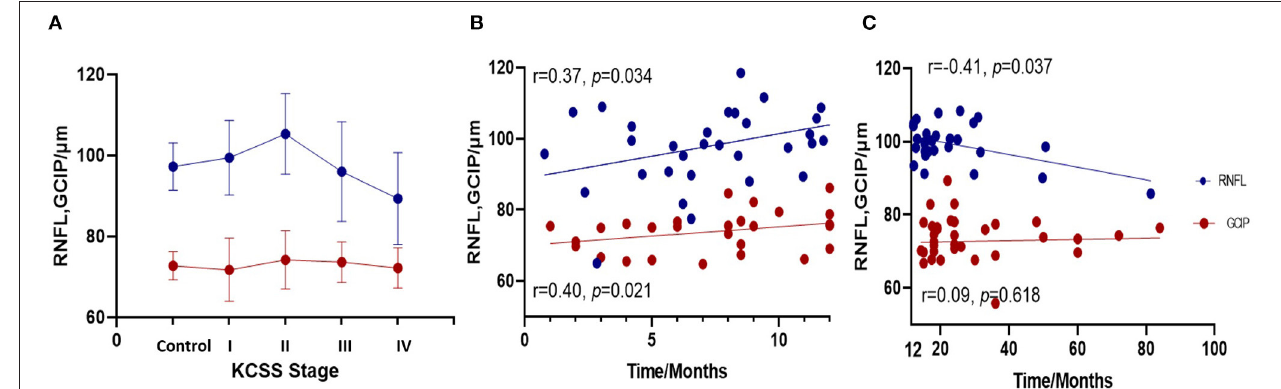
FIGURE 2 | Correlation analysis between disease duration and RNFL and GCIP. (A) When patients were divided into four groups by disease progression based on KCSS, the RNFL remarkably increased ( r = 0.464, p < 0.001) during the early stage and then significantly declined as the disease progressed ( r = − 0.324, p = 0.047), forming an inverse U-shaped trajectory. (B) In the first 12 months, the RNFL and GCIP thickened as the disease progressed ( r = 0.37, p = 0.034). (C) After 12 months, the RNFL declined ( r = − 0.41, p = 0.037), but no significant correlation was found between the GCIP and disease duration.